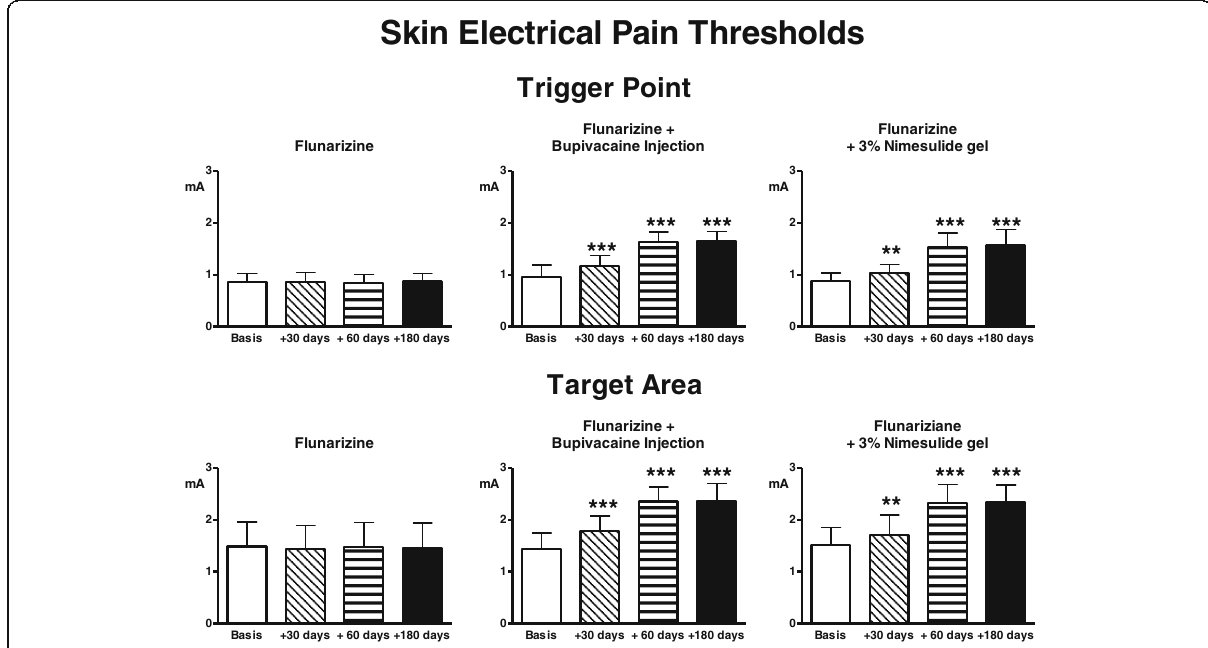
Fig. 3 Pain thresholds to electrical stimulation of the skin overlying the trigger point and the target area. Legend as for Fig.